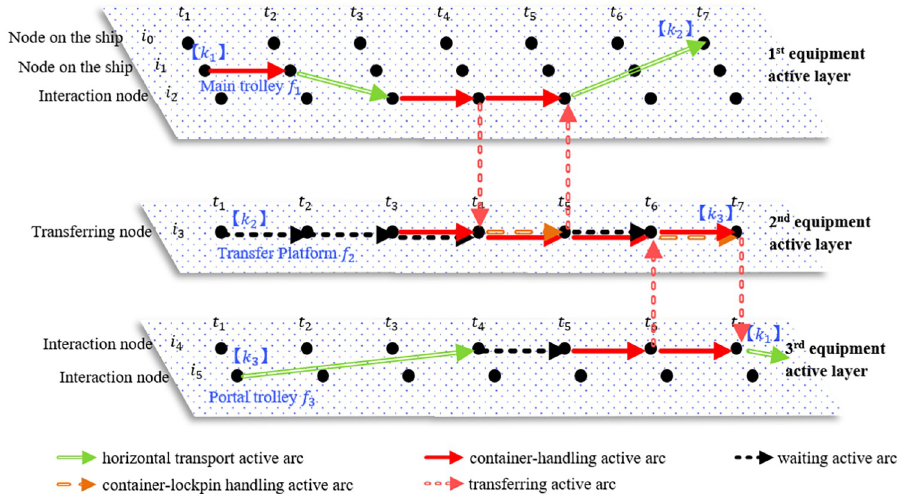
Fig 6. An example of the space-time representation of the cooperative operation of the